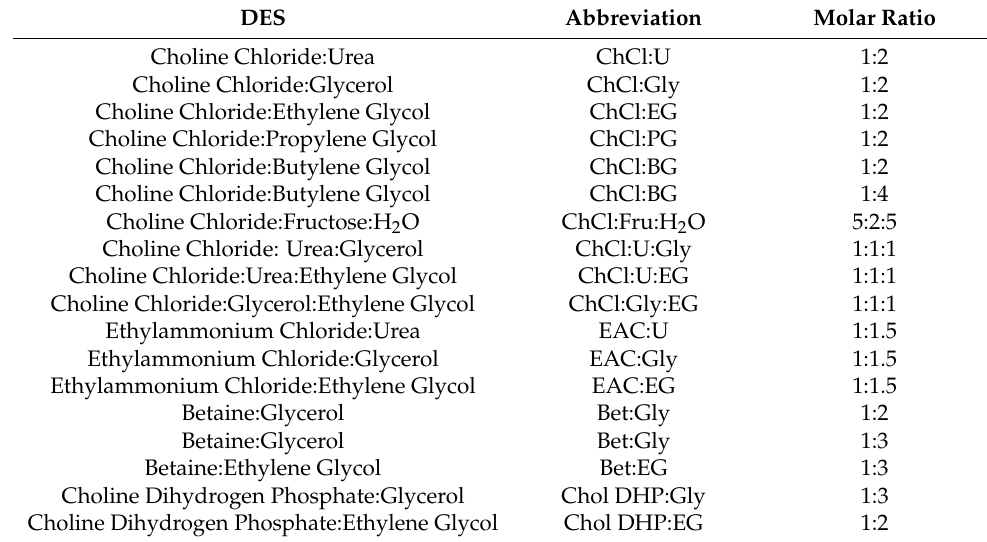
Table 1. DESs prepared in the current